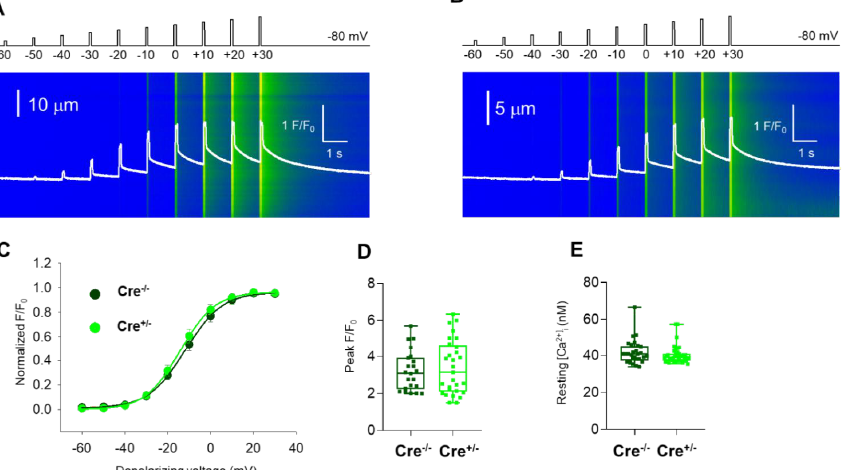
Figure 4. Unaffected resting intracellular calcium levels and release channel sensitivity to activation in fibers from Cre +/ − mice. Intracellular Ca 2+ transients were recorded under whole-cell voltage clamp following Rhod-2 loading, with 100 ms-long gradually increasing membrane depolarization rang- ing between −6 0 mV and +30 mV, with 10 mV increments applied every 500 ms in single FDB fibers from Cre − / − ( A ) and Cre +/ − ( B ) mice. Fluorescence was normalized to average resting F 0 ( x ). The white traces illustrate the spatially averaged F( t )/F 0 . ( C ) Data points represent the normalized maximal fluorescence at the given depolarization in 21 Cre − / − and 27 Cre +/ − FDB muscle fibers obtained from 6 animals in each group. The voltage dependence of the normalized fluorescence was well fitted by a Boltzmann function using Equation (1). The mean values of parameters V 50 and k were not signifi- cantly different: V 50 (Cre − / − ): − 11.7 3 ± 2 .1 mV, k (Cre − / − ): 8.4 9 ± 0 .6 mV, and V 50 (Cre +/ − ): −1 4.1 1 ± 2 .4 mV, k (Cre +/ − ): 7.9 9 ± 0 .6 mV. ( D ) Box plot distribution of the average peak of calcium transients elicited by single 100 ms-long depolarizations to +30 mV in Cre − / − ( n = 21 cells, N = 6 mice) and Cre +/ − fibers ( n = 27 cells, N = 6 mice). The average peak F/F 0 values were: 3.2 2 ± 0 .23 and 3.4 1 ± 0 .27. ( E ) Box plot representation of the resting intracellular calcium concentration as measured by Fura-2 ratiometric dye. The average resting calcium concentration values were: 41. 8 ± 6 .6 nM for Cre − / − ( n = 29 cells) and 40. 3 ± 4 .9 nM for Cre +/ − ( n = 40 cells), respectively.